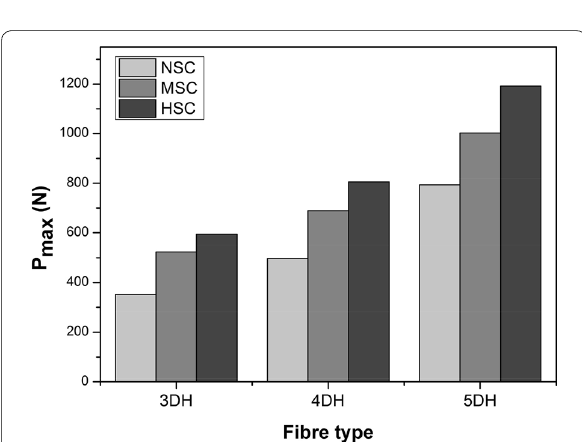
Fig. 9 Maximum pull-out load (P max ) of 3DH, 4DH and 5DH hooked end